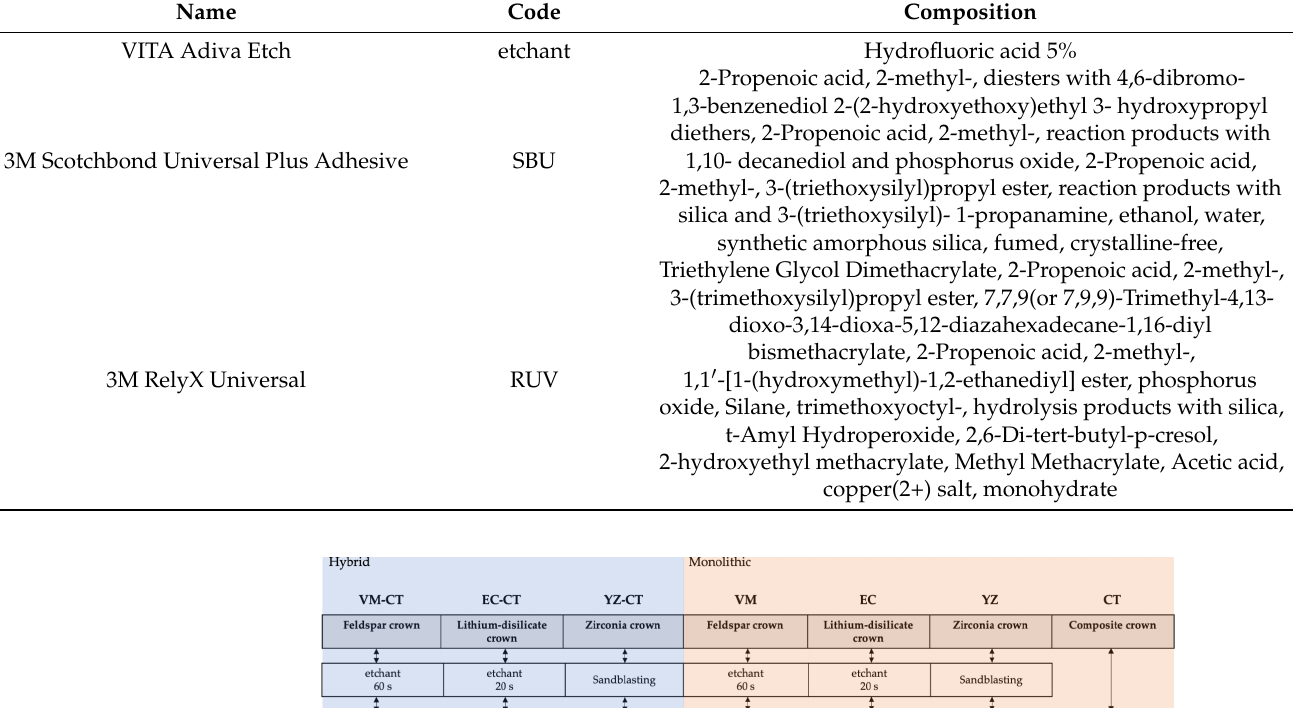
Table 2. Resin composite cement and primer used (material compositions according to the manufac- turers’ product specifications).